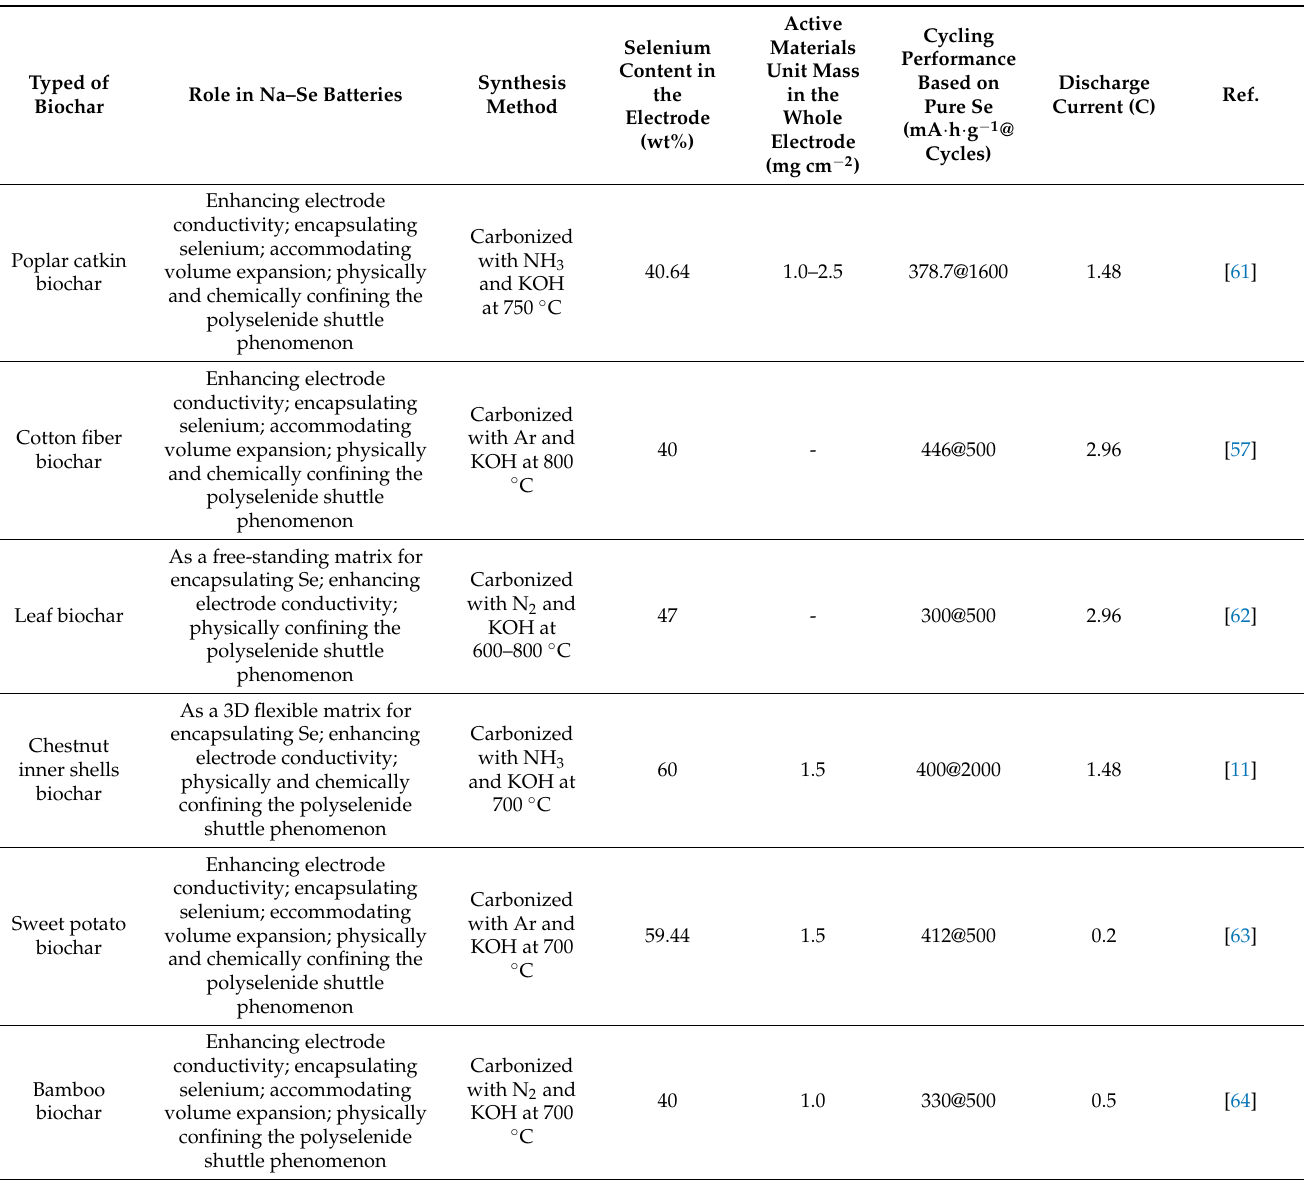
Table 2. Biomass-derived carbon materials utilization in Na–Se